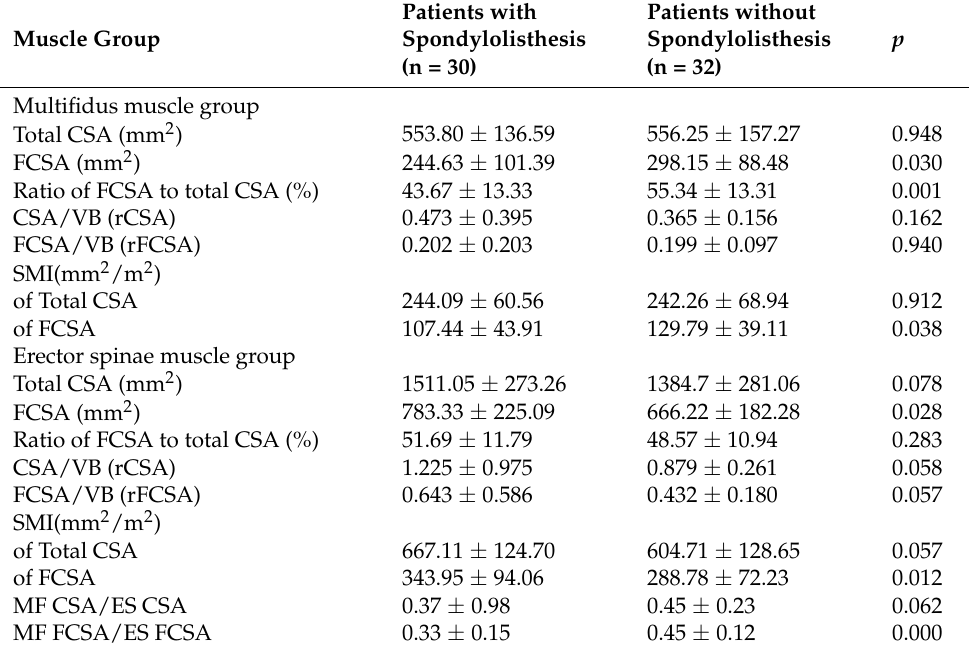
Table 4. Magnetic resonance imaging findings for multifidus and erector spinae muscle groups by degenerative lumbar